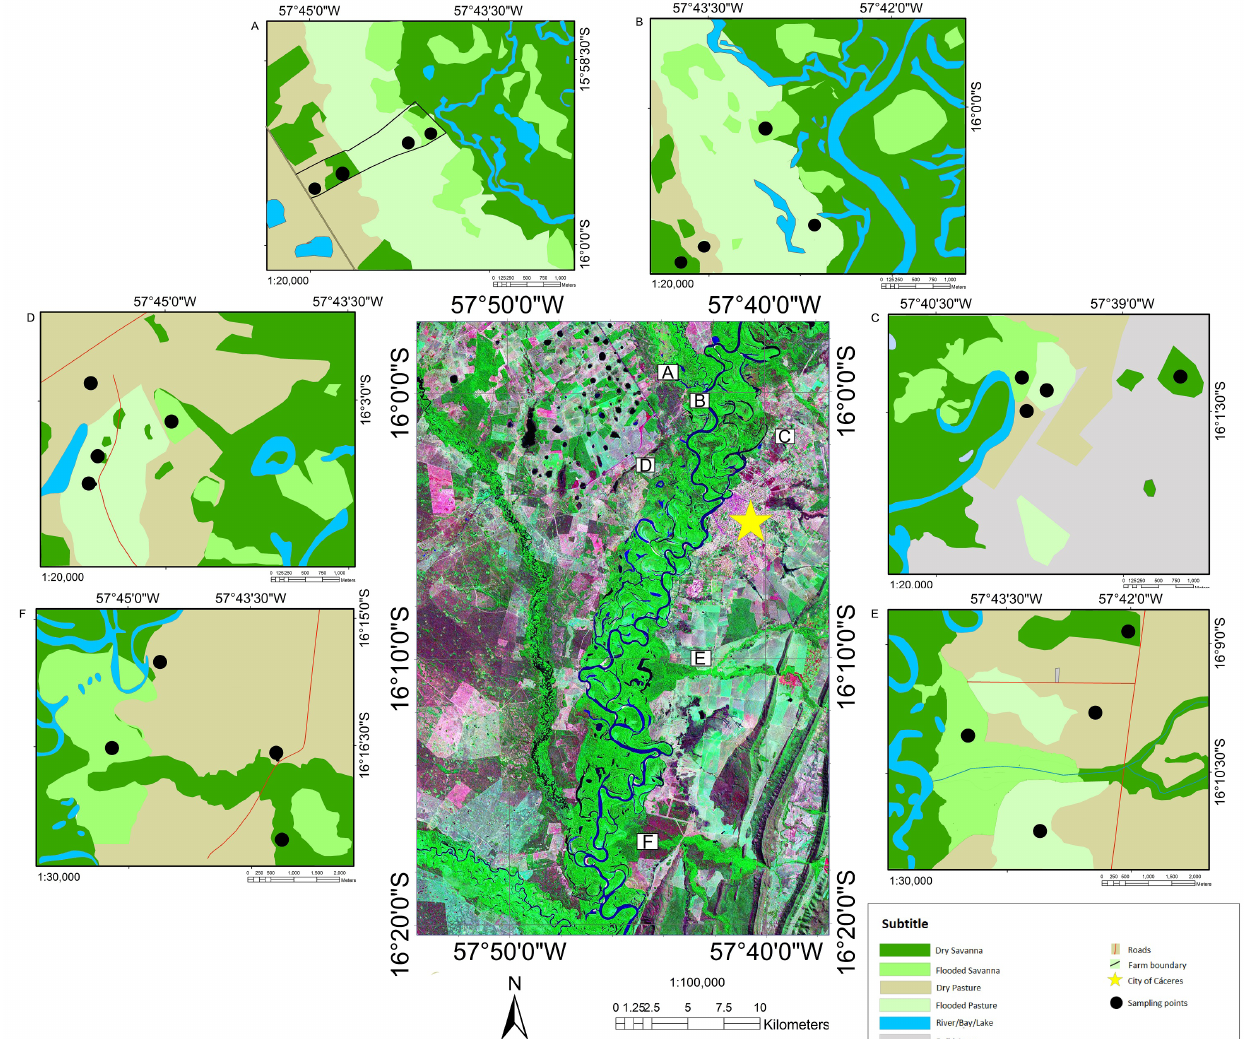
Fig 1 . Map of land use and occupation of the sampled areas in different Paraguay River bays in the Pantanal of Cáceres, Mato Grosso state , Where the areas are determined by the letters (A –